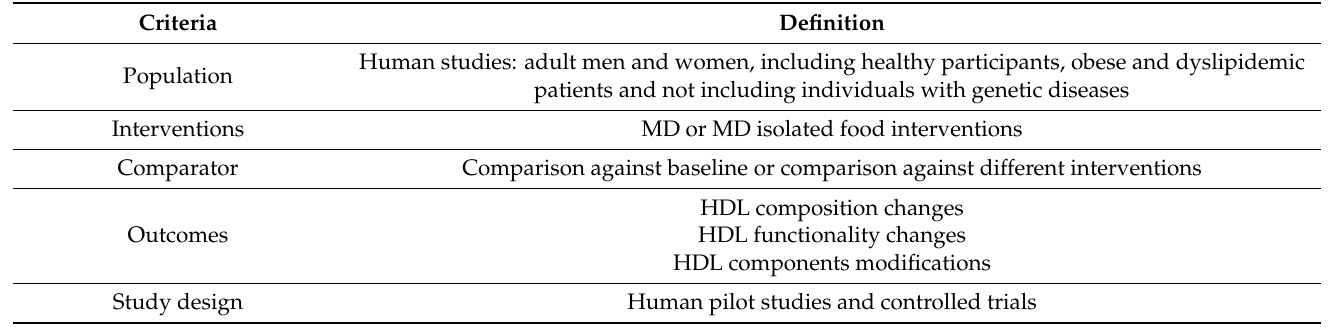
Table 1. Population, intervention, comparator, outcome, and study design (PICOS) model of eligibility criteria.